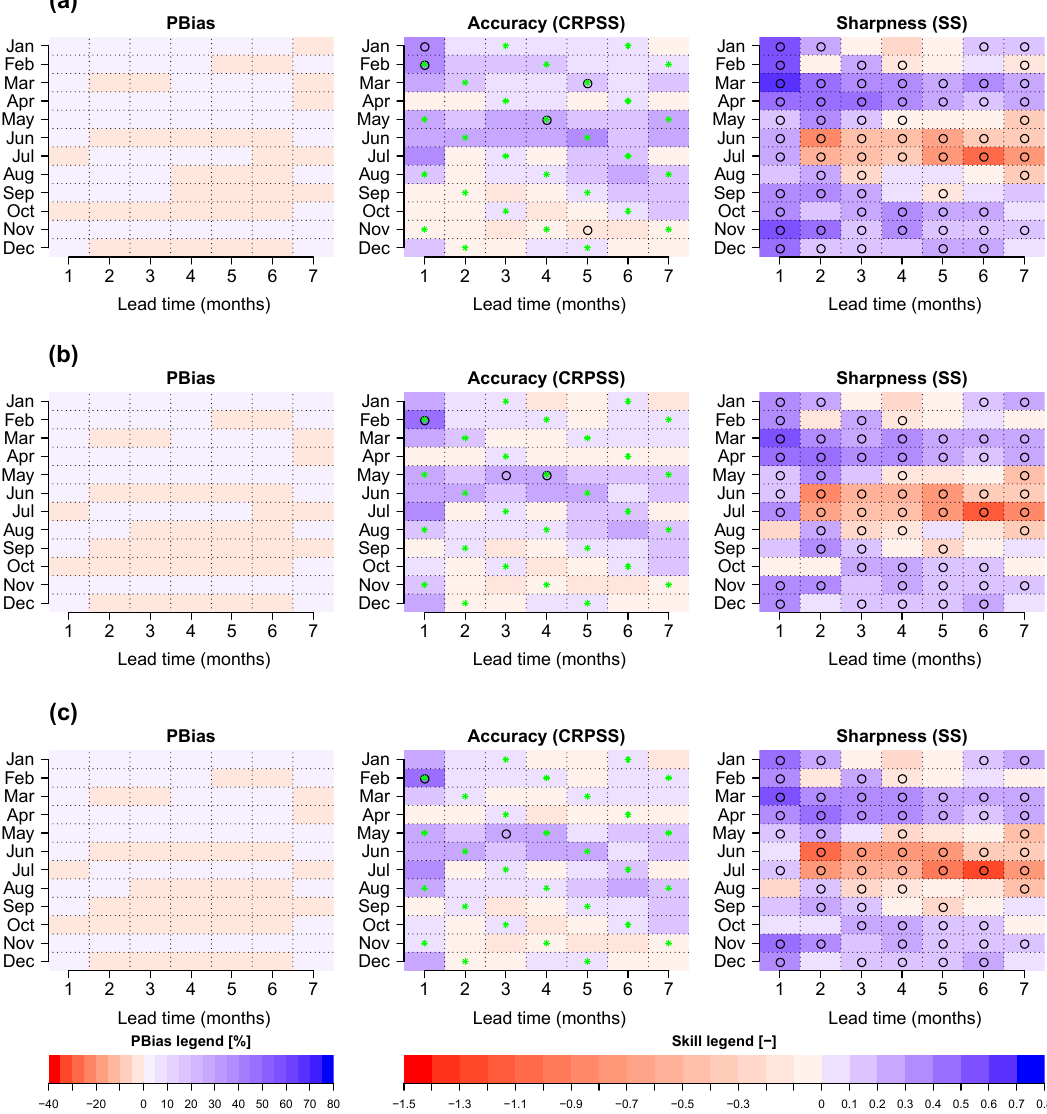
Figure 7. PBias and skill (sharpness and accuracy) of daily monthly mean streamflow forecasts for post-processed forecasts using the quantile mapping (QM) method for predictions generated using raw (a) and preprocessed meteorological forcings with the linear scaling/delta change (b) and quantile mapping (c) methods. Legend is the same as Fig. 5. Green crosses represent the months/lead times were the ensemble size is